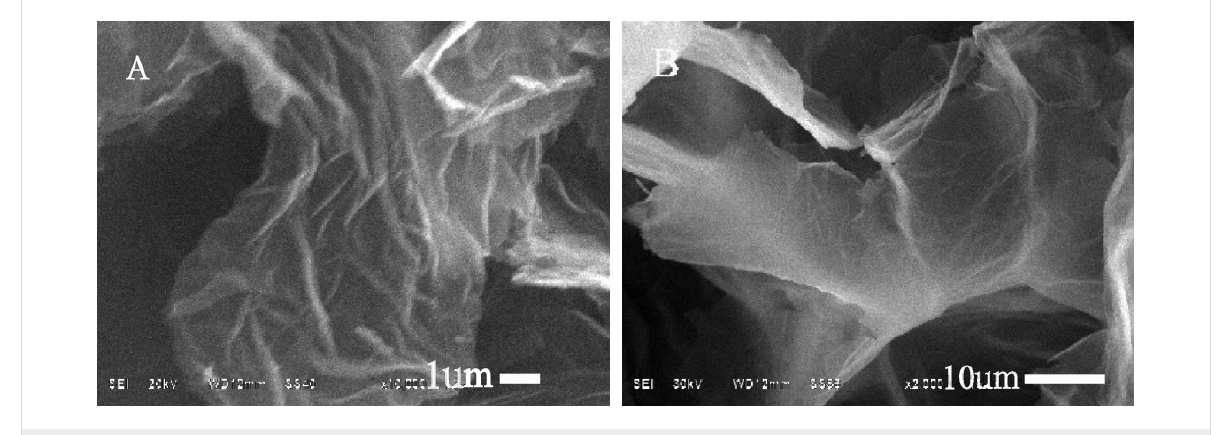
Figure 3: SEM images of Lys-GO (A) and GO (B).